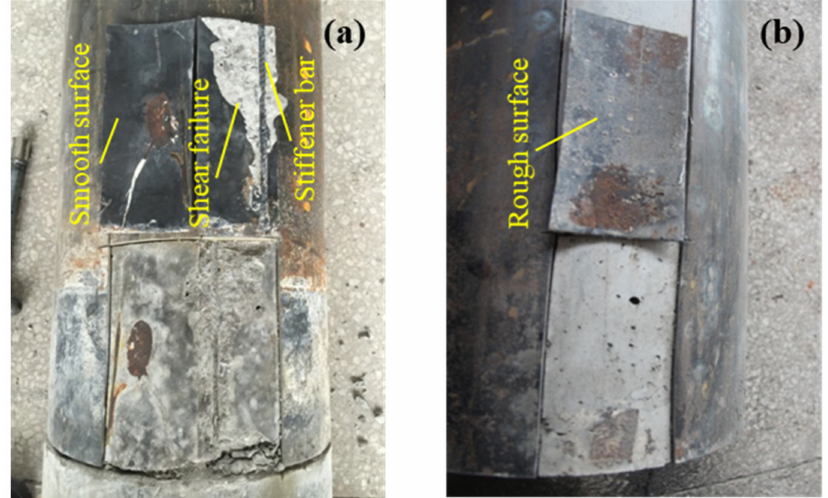
Figure 8. Bond state of steel and concrete interface: ( a ) The lower part of RSCFST; ( b ) The upper part of